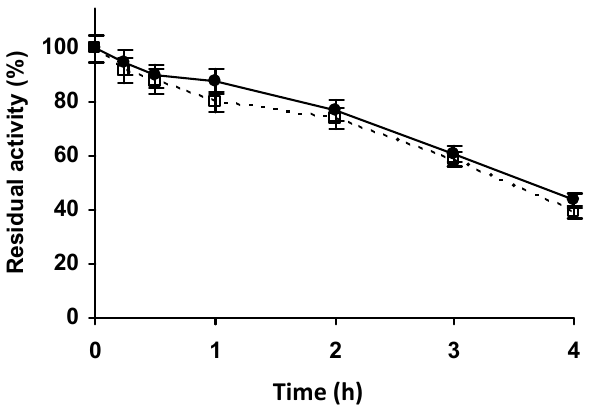
Catalysts 2021 , 11 , x FOR PEER REVIEW 11 of 22